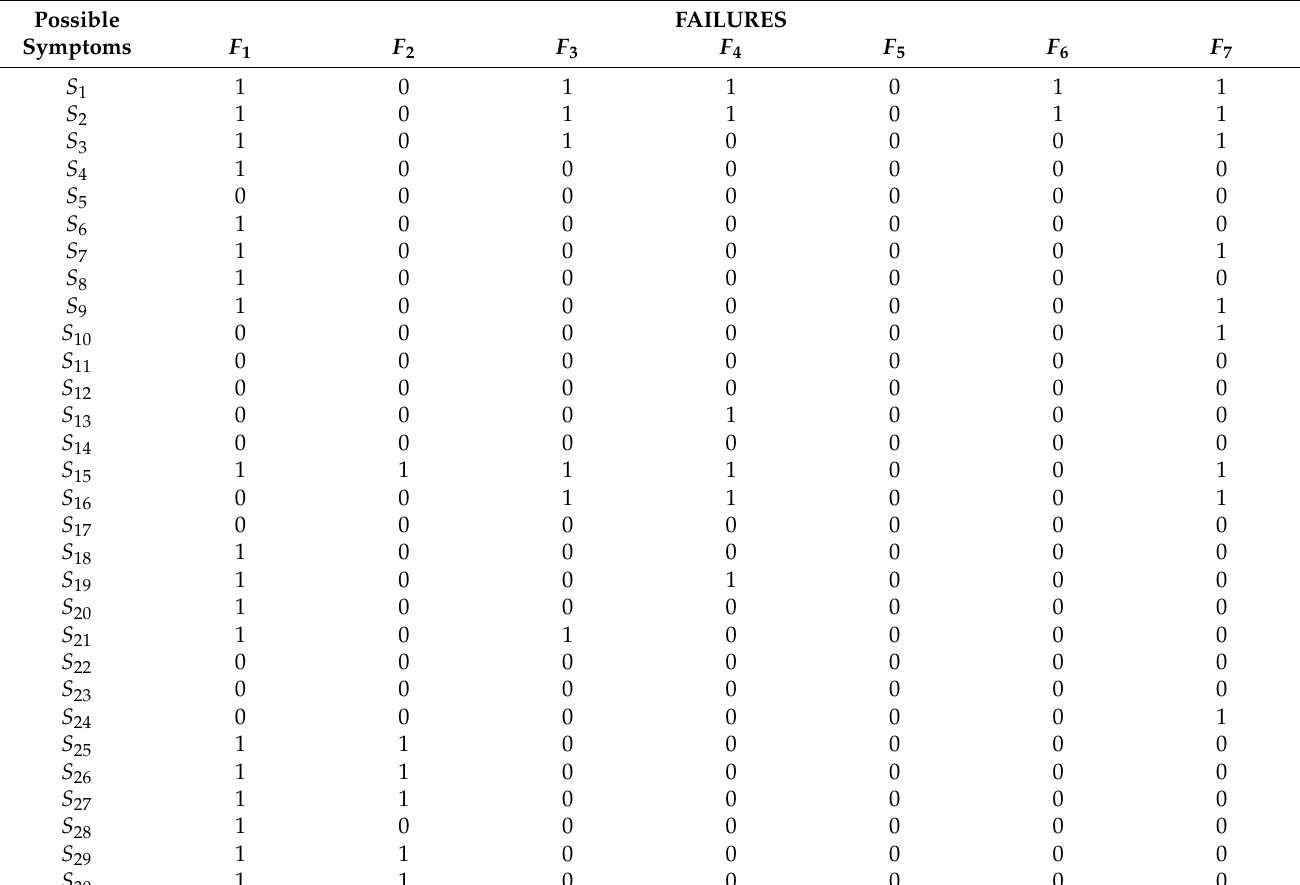
Table 4. The binary elements of the binary diagnostic matrix ( BDM ) determined as a result of the experimental